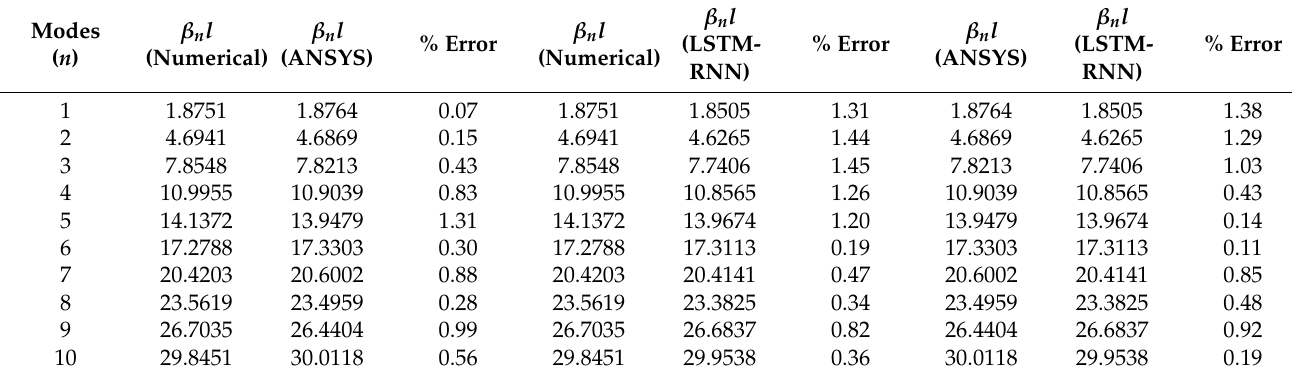
Table 5. Comparative analysis of the transcendental roots ( β n l